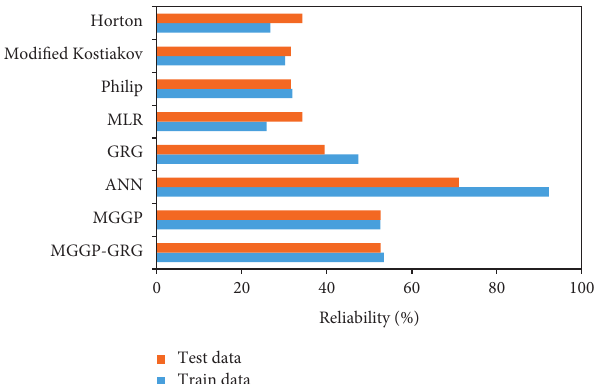
Figure 14: Results of the reliability analysis for train and test